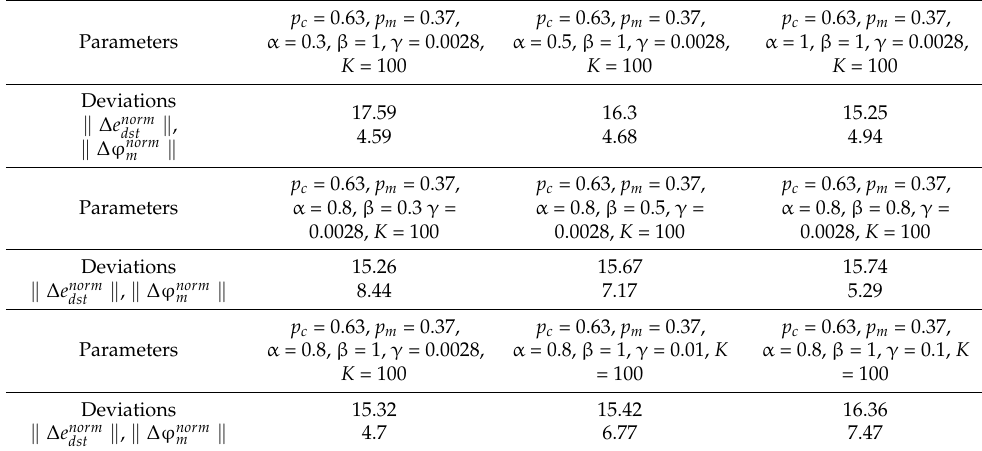
Table 1. The deviations of distributions (cid:107) ∆ e norm algorithm